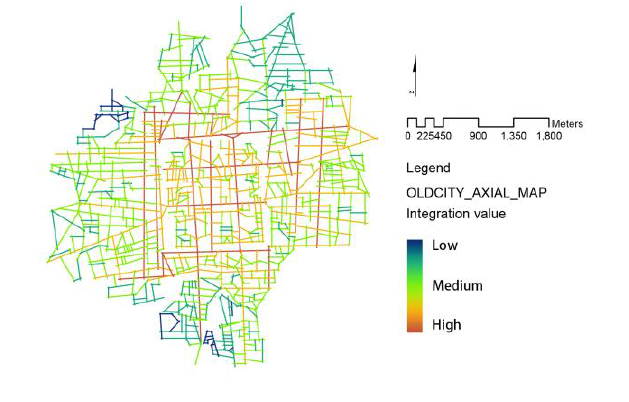
Figure 1. GIV of Shenyang old